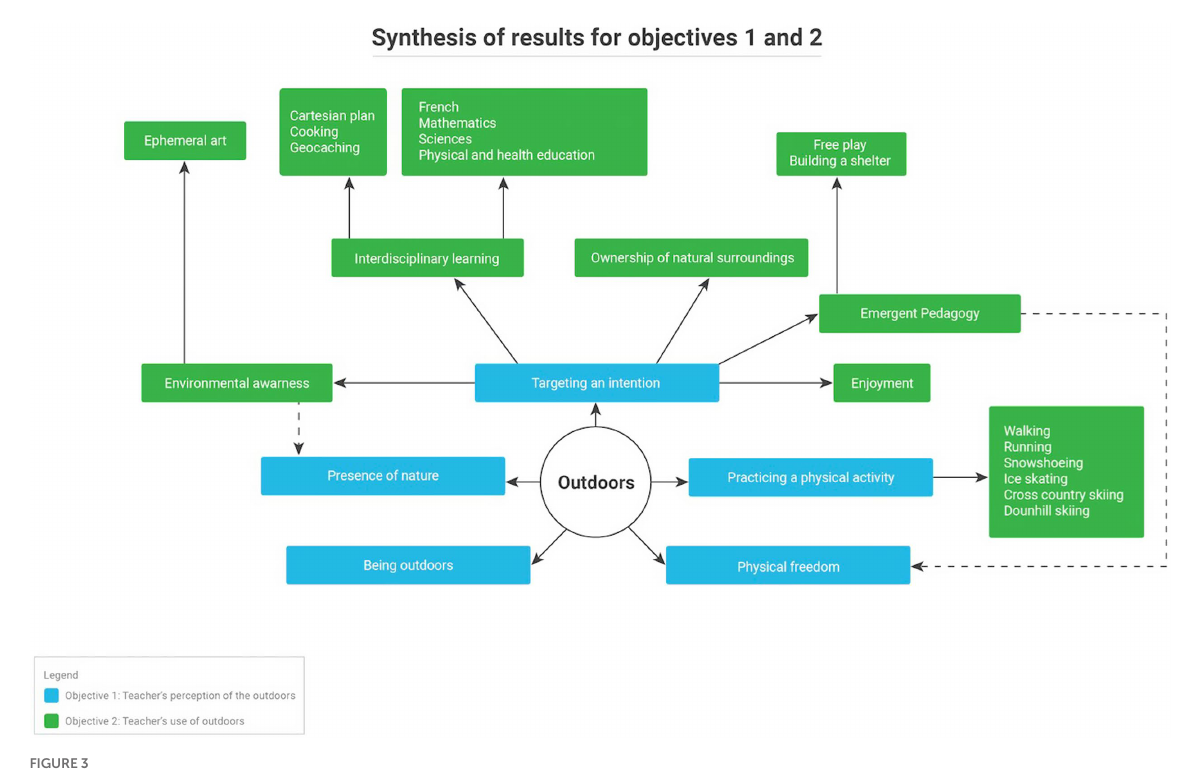
FIGURE 3 Synthesis of results for objectives 1 and